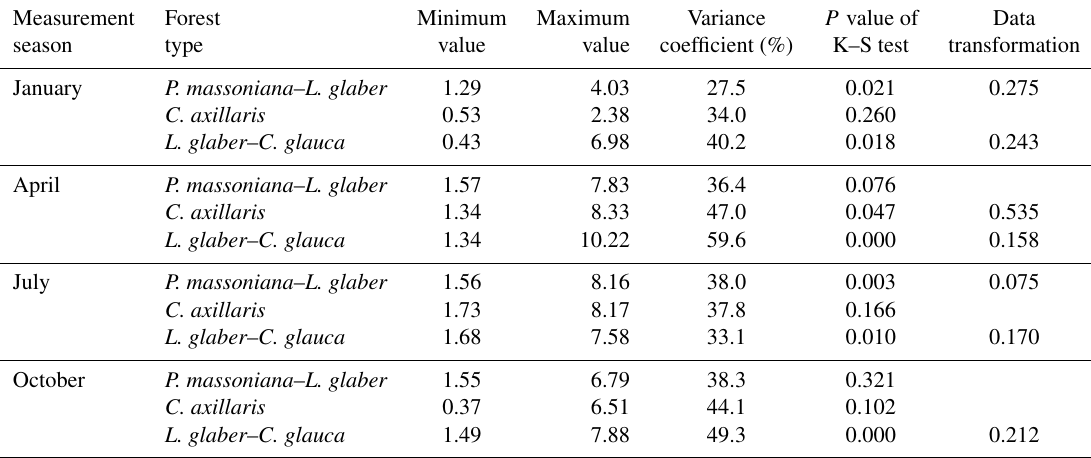
Table 1. Descriptive statistical characteristics of LAI values measured from April 2014 to January 2015 in P . massoniana – L . glaber , C . axillaris , and L . glaber – C . glauca forests ( n = 100).